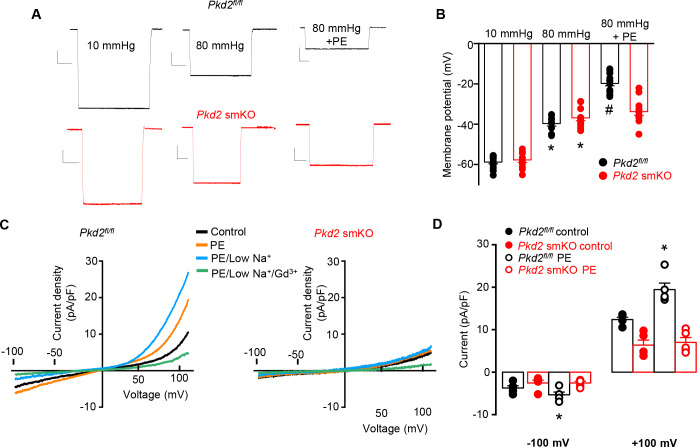
PKD2 channels contribute to phenylephrine-induced mesenteric artery depolarization and INa in mesenteric artery myocytes.(A) Representative traces of microelectrode impalements illustrating that phenylephrine (PE, 1 µM)-induced depolarization is attenuated in mesenteric arteries of Pkd2 smKO mice. Scale bars: Y = 10 mV, X = 20 s. (B) Mean membrane potential recordings in pressurized (10 and 80 mmHg) mesenteric arteries and in PE at 80 mmHg (Pkd2fl/fl: 10 mmHg, n = 13; 80 mmHg, n = 9; 80 mmHg + PE, n = 15. Pkd2 smKO: 10 mmHg, n = 11; 80 mmHg, n = 12; 80 mmHg + PE, n = 12). *p<0.05 versus 10 mmHg in the same genotype. # p<0.05 versus 80 mmHg in the same genotype. (C) Original current recordings obtained between −100 and +100 mV in the same Pkd2fl/fl and Pkd2 smKO myocytes in control, PE (10 μM), low Na+ (40 mM)+PE and low Na+ (40 mM)+PE + Gd3+ (100 µM). (D) Mean paired data (Pkd2fl/fl, n = 5; Pkd2 smKO, n = 5; *p<0.05 versus control in the same genotype).